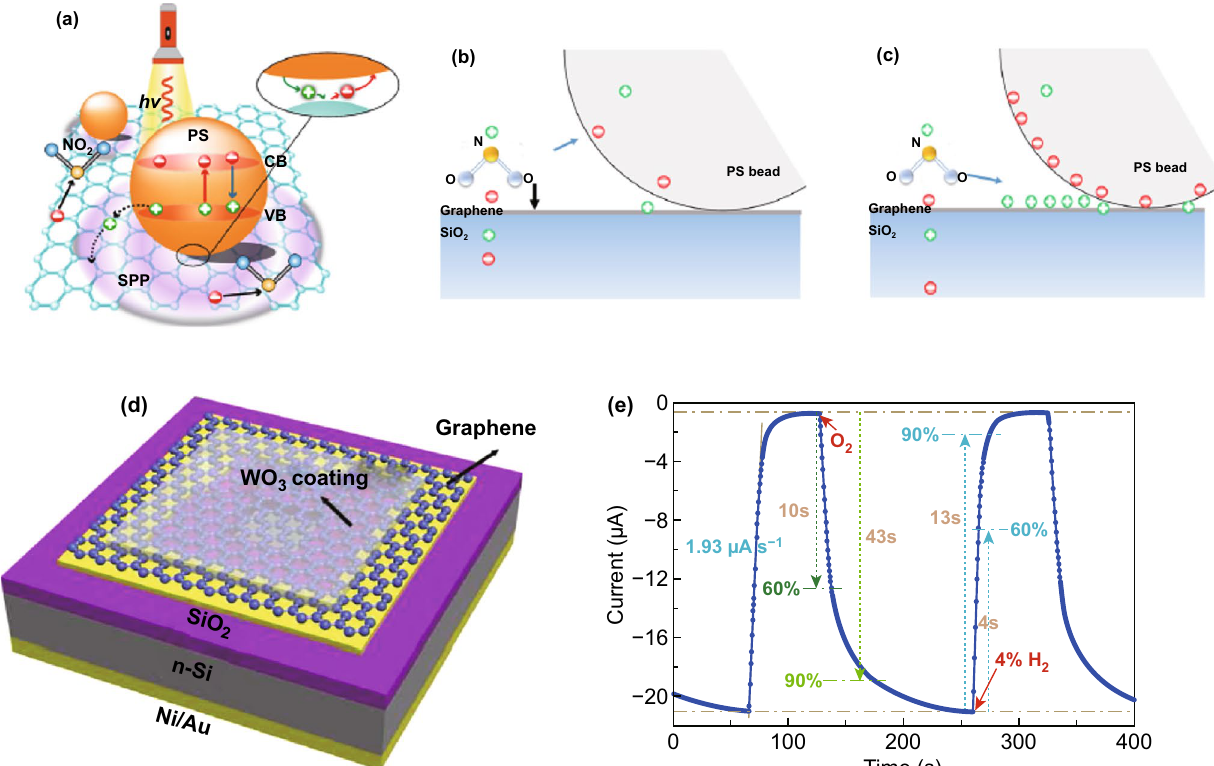
Fig. 10 a Schematic representation of charge transfer in between graphene and PS bead under light illumination. The electric potential and static forces on adsorbed NO 2 molecules on graphene/PS hybrid under b dark condition and c light illumination. Reproduced with permission [93]. Copyright 2019, American Chemical Society. d Schematic illustration of gasochromic-Pd-WO 3 /graphene/Si tandem structure of hydrogen sensor. e The transient gas response of the sensor to H 2 gas under light illumination. Reproduced with permission [102]. Copyright 2018, Else-